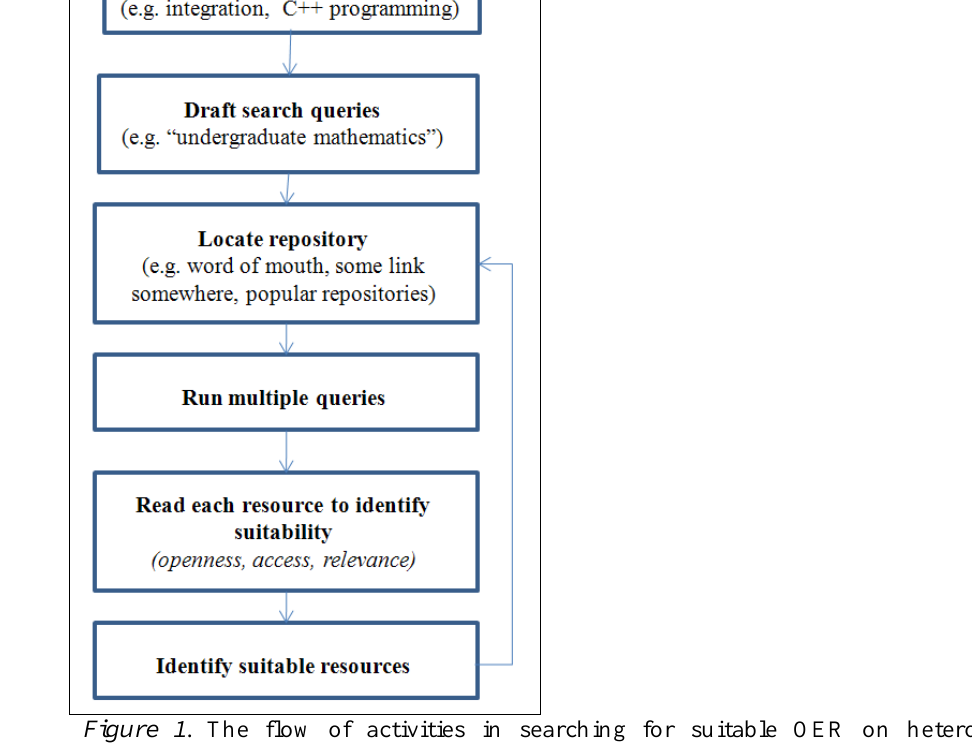
Another factor inhibiting effective OER search is the heterogeneity of